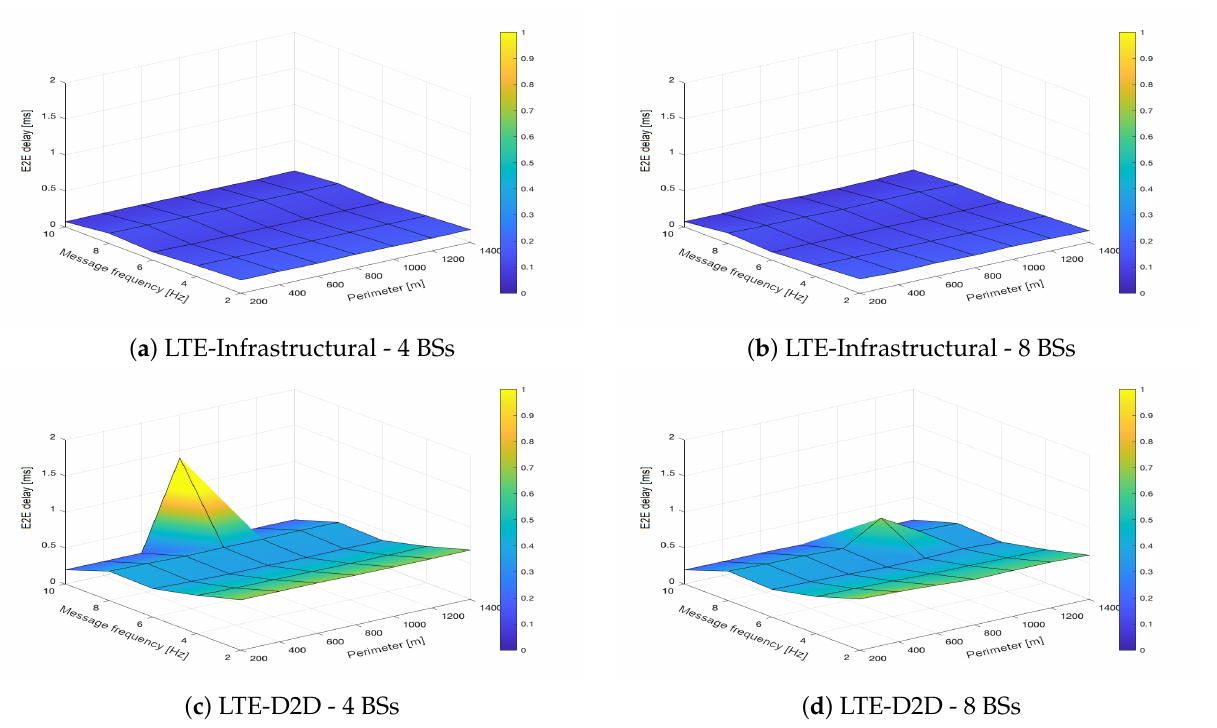
Figure 19. E2E latency simulated for the both modes of the 4G-based C-V2X technology, both infrastructure density deployments and traffic intensity of 1500 vehicles per hour.